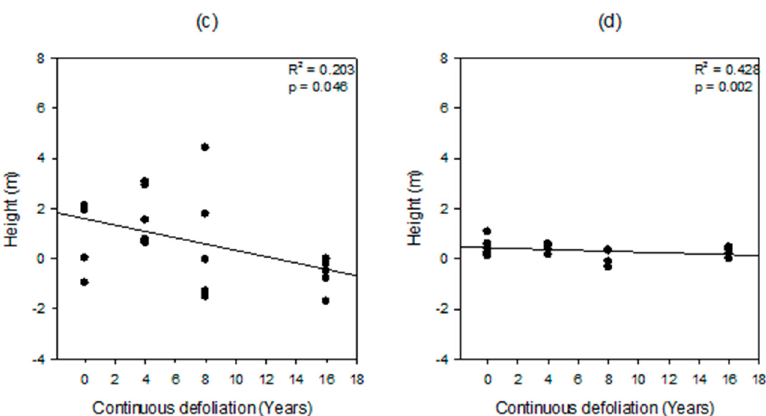
Figure 6. The distance between selected vertical stand components (dependent variables) by years of continuous spruce budworm defoliation (independent variable) from 1993–2008 in boreal mixedwood forest near Warren, Ontario: ( a ) Host overstory crown and downed woody debris (Overstory CBH − DWDH); ( b ) Host overstory crown, host understory crown and downed woody debris (Overstory CBH − Understory H + Understory CBH − DWDH); ( c ) Host overstory and understory crowns (Overstory CBH − Understory H); and ( d ) Host understory dead crown and downed woody debris (Understory DCBH − DWDH). For all four categories of number of years of continuous defoliation, n = 5.